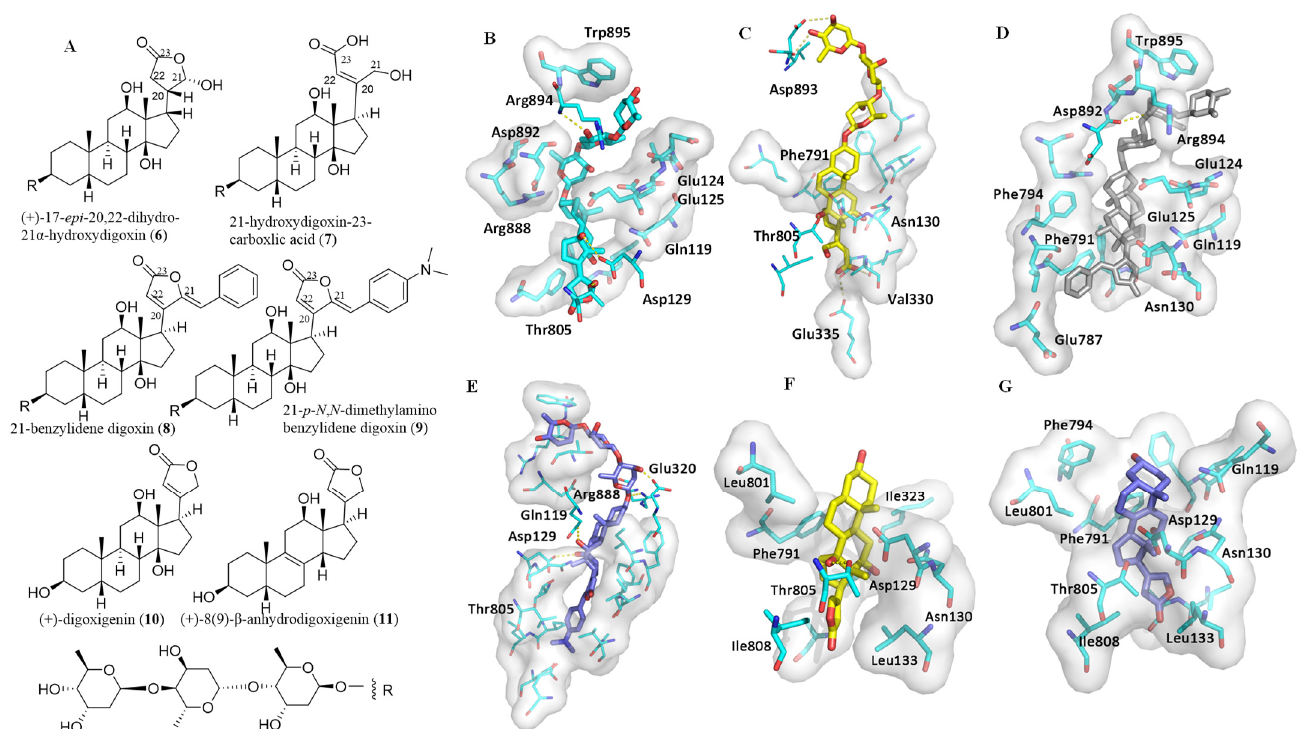
Figure 3. Docking profiles for (+)-17- epi -20,22-dihydro-21 α -hydroxydigoxin ( 6 ), 21-hydroxydigoxin-23-carboxlic acid ( 7 ), 21-benzylidene digoxin ( 8 ), 21- p - N , N -dimethylaminobenzylidene digoxin ( 9 ), (+)-digoxigenin ( 10 ), and (+)-8(9)- β -anhydrodigoxigenin ( 11 ) with NKA. ( A ) Structures of 6 – 11 . ( B – G ) Docking profiles for 6 (cyan, B ), 7 (yellow, C ), 8 (gray, D ), 9 (blue, E ), 10 ( F , yellow), and 11 (blue, G ) with NKA.